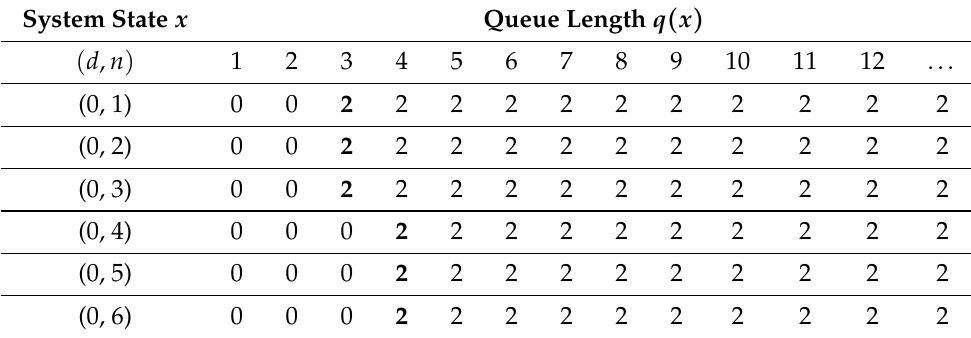
for the queue Q 1 . 1